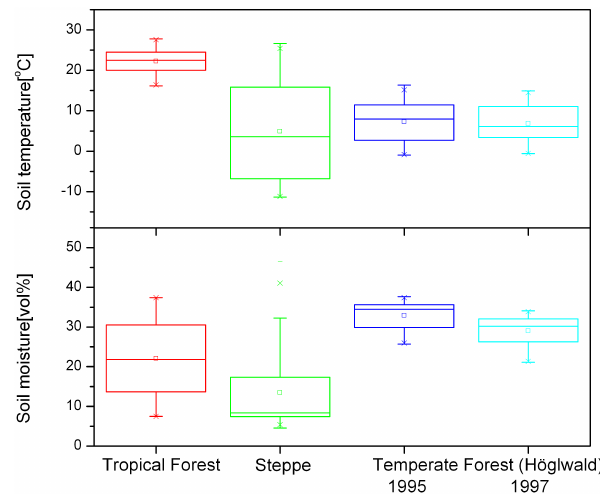
Fig. 4. Box plot of average daily soil volumetric water content and soil temperature for the three investigated ecosystem types: tropical forest, semi-arid steppe, and temperate forest (H¨oglwald forest: data both in years 1995 and 1997). The boxes are determined by 25th and 75th percentiles. The whiskers are determined by the 5th and 95th percentiles. Additional values can be represented in box chart, including the minimum and maximum (dashes), median (line in the box), mean (square), 1st percentile and 99th percentiles (crosses)